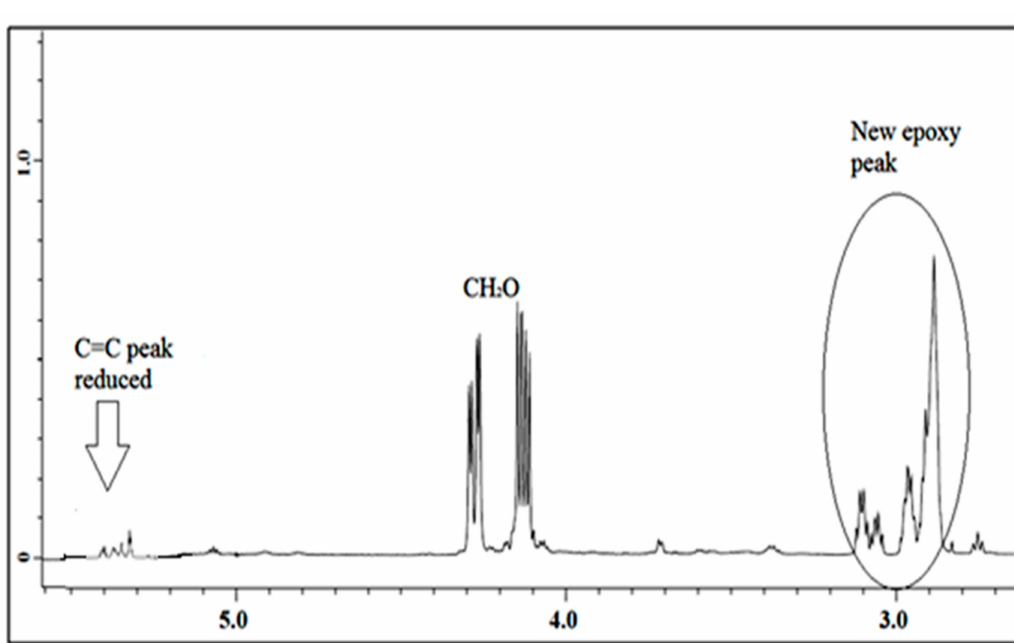
Figure 5. 1 H NMR of epoxidized jatropha